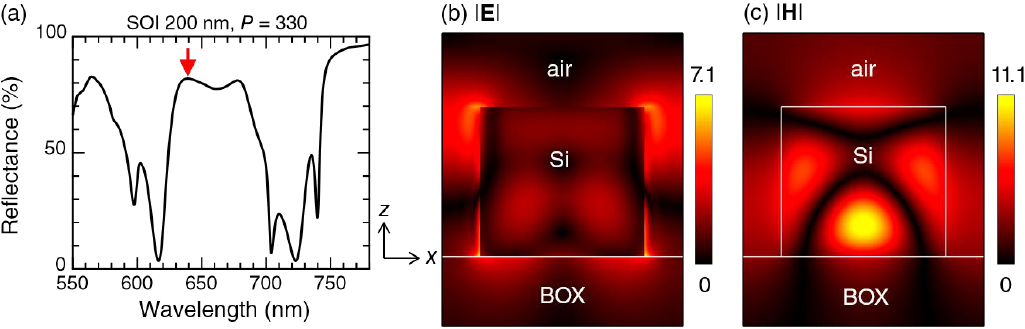
Figure 5. ( a ) Numerically calculated R spectrum for the metasurface of a SOI of 200 nm thickness and P = 330 nm. Incidence was assumed to be normal. ( b , c ) xz -section-view | E | and | H | distributions, respectively, at a highly FL-enhancing wavelength (639.3 nm), indicated by the red arrow in ( a ). Incident | E | and | H | were set to 1.0.